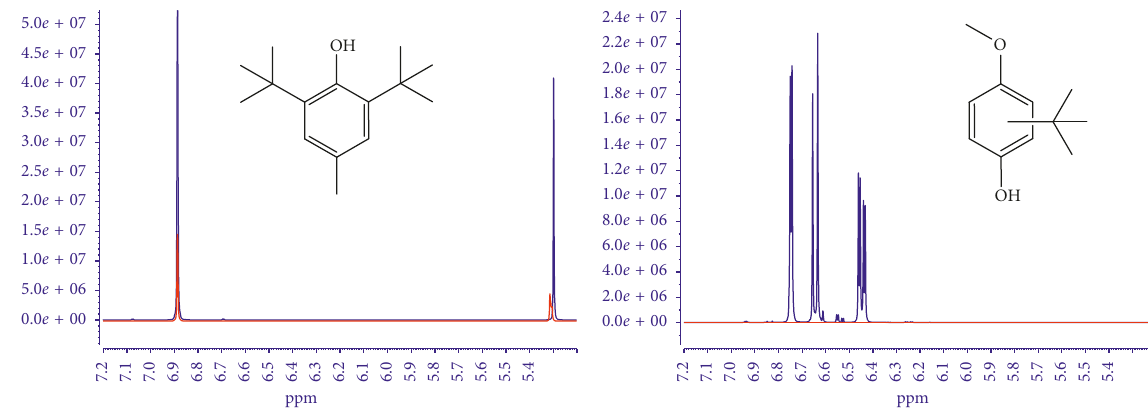
Figure 4: Comparison of BHT (a) and BHA (b). The blue 1 H NMR spectra show the signals of a direct measurement in cyclohexane/ acetone-d 6 , while the red spectra represent the result of the SPE cleanup. While BHA is completely removed by SPE, a considerable amount of BHT